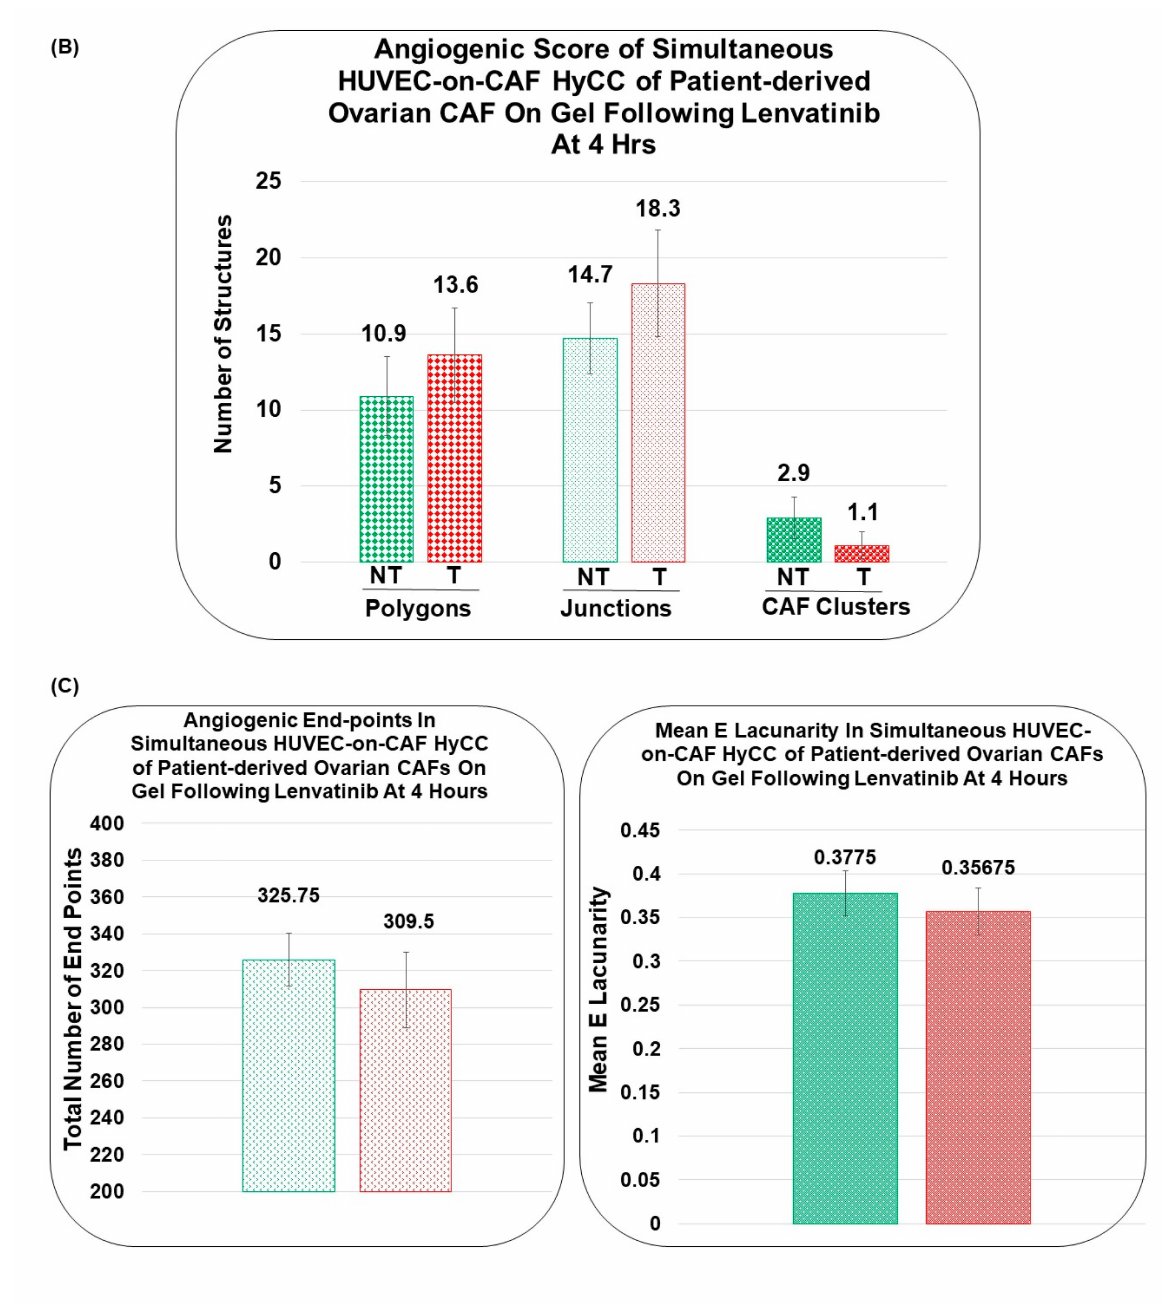
Figure 9. Effect of Lenvatinib on ex vivo on − gel simultaneous hybrid co − culture of HUVEC on Patient − Derived primary ovarian CAF for 4 h: We performed simultaneous Hybrid Co-culture of HUVEC on Patient-Derived primary ovarian CAF for 4 h on-gel following lenvatinib. Angiogenic Scores ( B ) are determined by the polygons, junctions, and CAF clusters (as represented by square boxes in photomicrographs of ( A )) as well as angiogenic endpoints and mean E lacunarity ( C ). Matrigel tube formation assay of HUVECs cultured in HyCC format with Patient-Derived ovarian CAFs in control medium (green) or in the presence of 1 microM of lenvatinib (red) for 4 h. Angiogenic Endpoints (total number) (represented in Divot bars) and the mean E lacunarity (represented in 40% filled bars) were detected with the AngioTool software (https://ccrod.cancer.gov/confluence/ display/ROB2/Home [(access on 9 August 2022)]). Bars represent the mean and standard deviation of the mean. Please note that the formation of CAF clusters was less in the simultaneous co-culture as compared to sequential